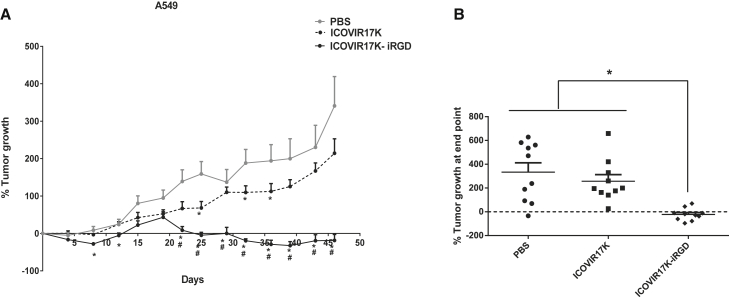
iRGD Improves the Oncolytic Efficacy of ICOVIR17K/VCN-01 in Nude MiceNude mice bearing A549 lung carcinoma subcutaneous tumors were systemically treated with a single dose of PBS or 4 × 1010/mouse of ICOVIR17K or ICOVIR17K-iRGD. (A) Percentage of tumor growth at the indicated days. Mean ± SEM is plotted (n = 10). Significance (*p < 0.05) by two-tailed unpaired Student’s t test compared with the PBS group (#p < 0.05) by two-tailed unpaired Student’s t test compared with the ICOVIR17K group. (B) Percentage of tumor growth distribution at the end of the experiment (day 46).